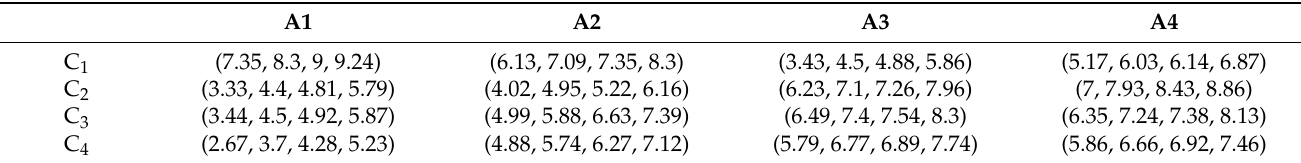
Table 7. Initial fuzzy EDAS-Z matrix.